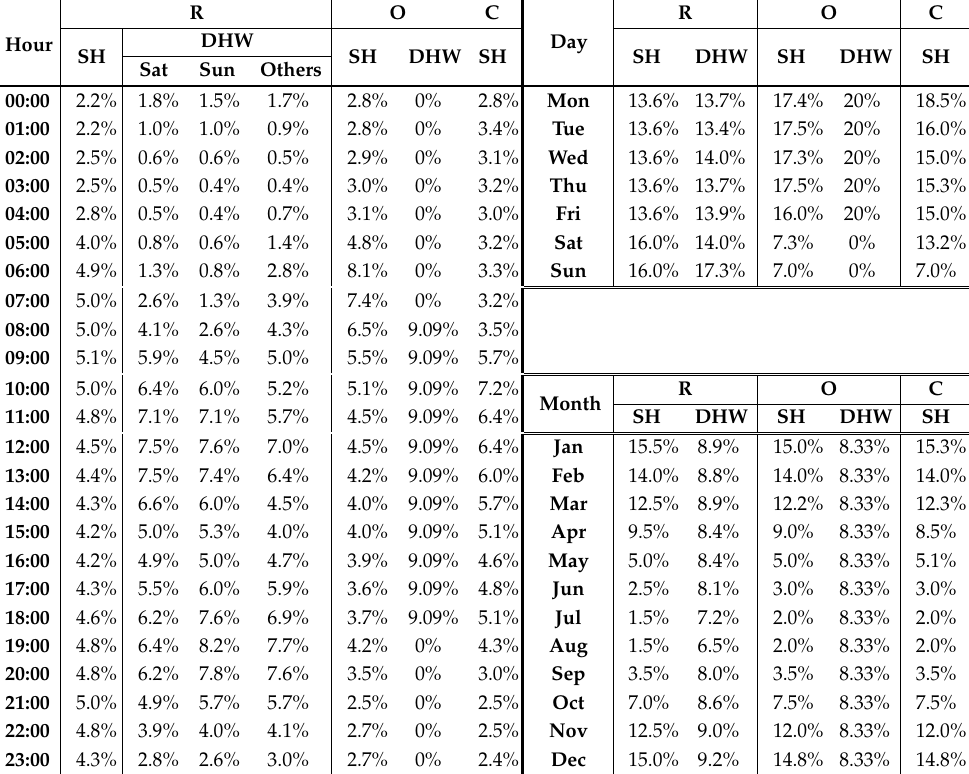
Table A2. Percentage distribution coefficients for space heating and domestic hot water consumption in residential (R), office (O), and commerce (C)